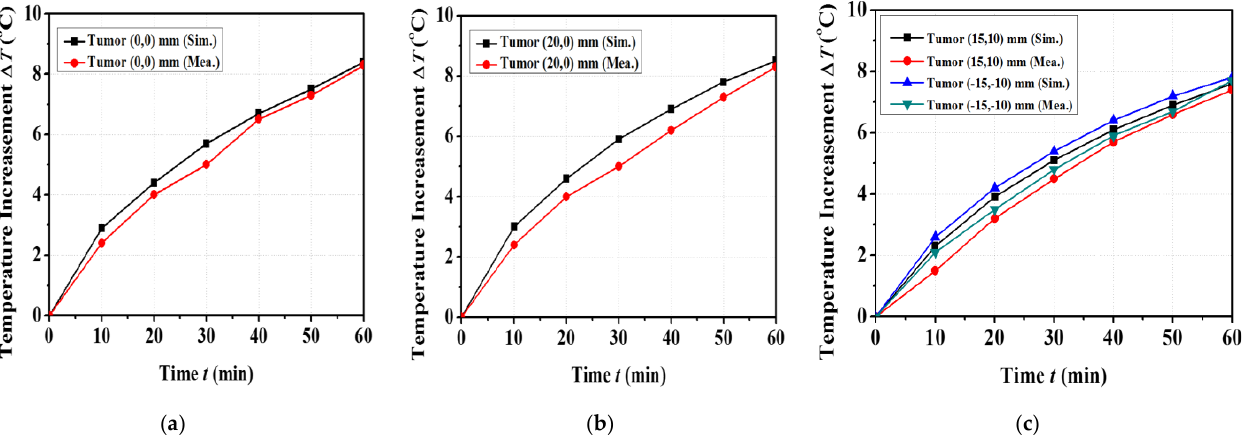
Figure 12. The 2D sections of temperature distribution after the 1-h heating on a single tumor at (0,0) mm: ( a ) simulation result and ( b ) measurement result. Temperature distribution after 1-h heating on a single tumor at (20,0) mm: ( c ) simula- tion result and ( d ) measurement result. Temperature distribution for 1-h heating on multiple tumors with phase compen- sation at (15,10) mm and (−15,−10) mm: ( e ) simulation result and ( f ) measurement result.